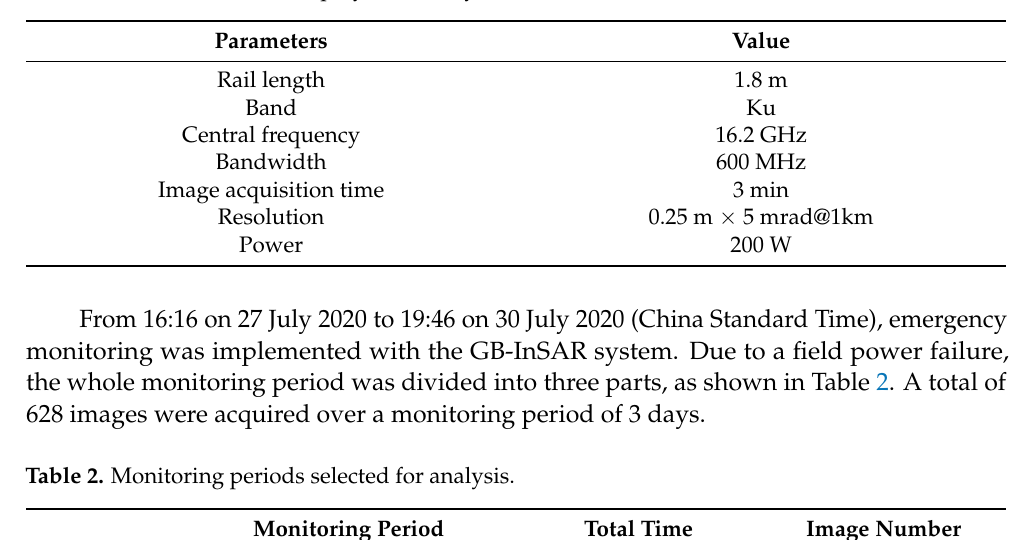
Table 1. Parameters of the employed radar system.